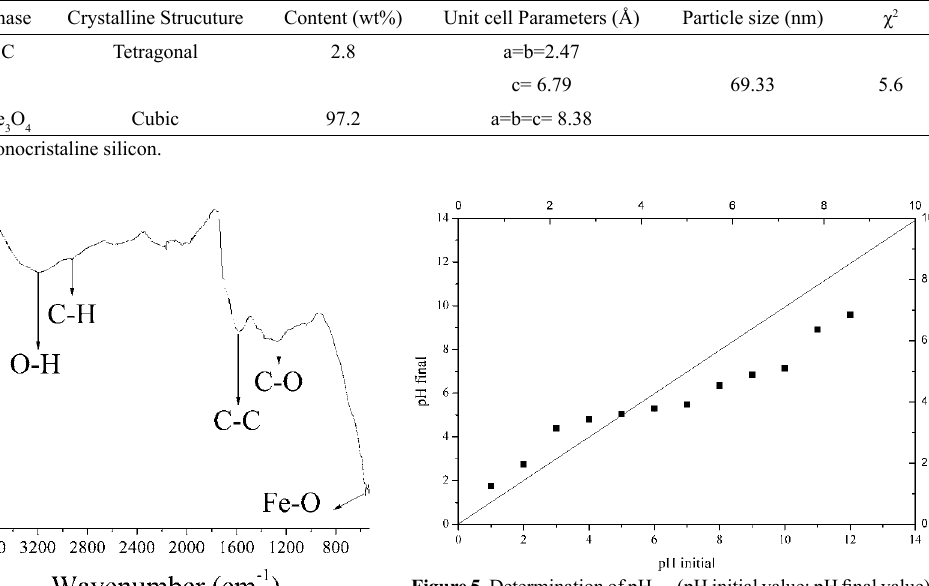
O @C nanoparticles. 3 4